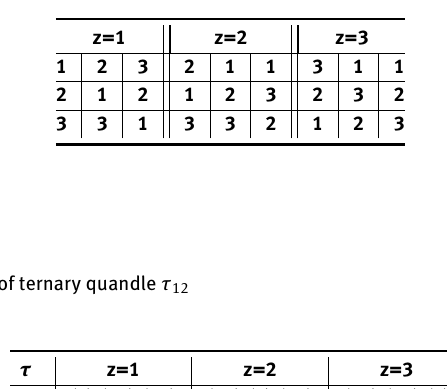
Table 1. Cayley representation of ternary quandle τ 12